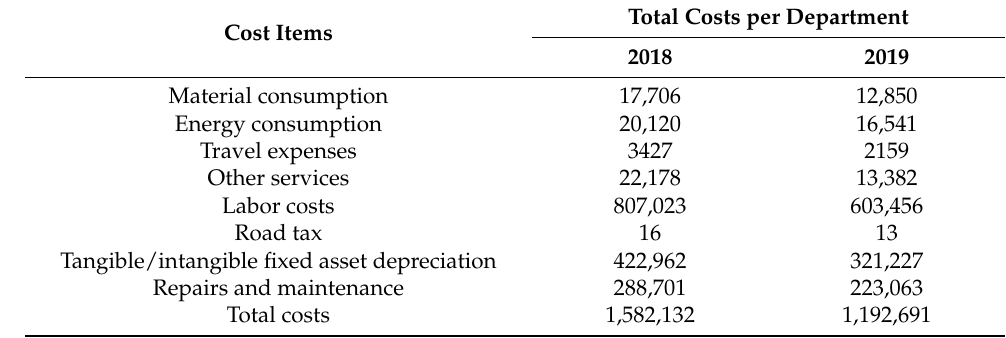
Table 4. Radiology department cost overview (EUR).